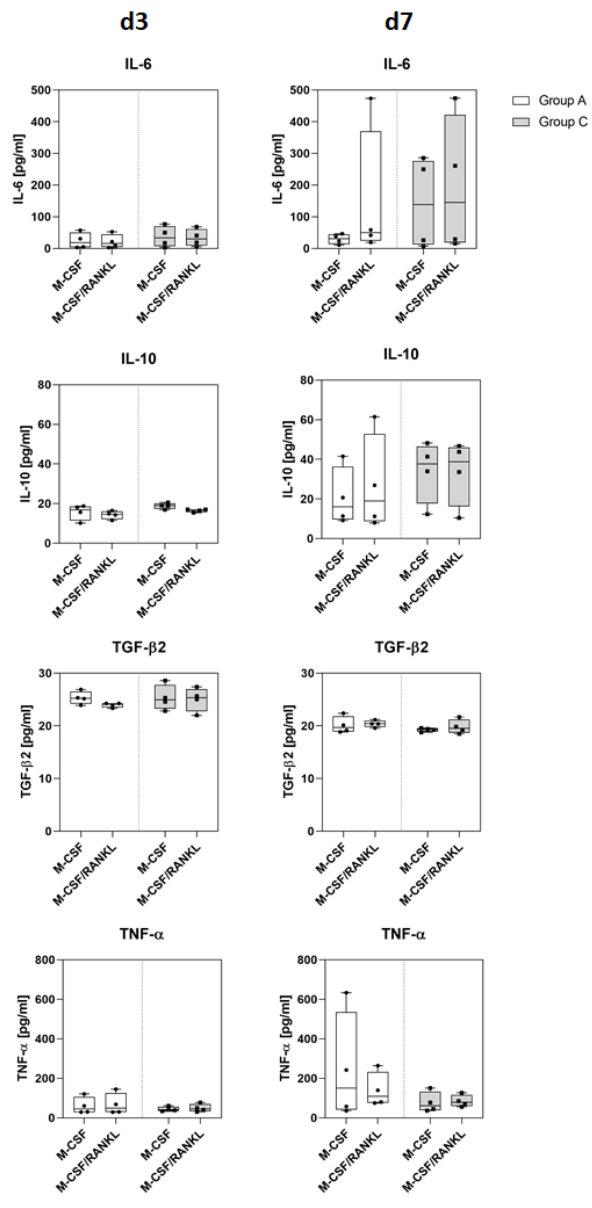
Figure 2. Secretion of inflammatory cytokines in PBMC of group A and group C. Cell culture supernatants were collected on day 3 and 7 from cells treated with either M-CSF or M-CSF/RANKL (n = 4). IL-6, IL-10, TGF- β 2 and TNF- α were quantified by ELISA. Data are given as median with interquartile range and min/max values, statistical analyses were performed using ANOVA and Tukey post-hoc